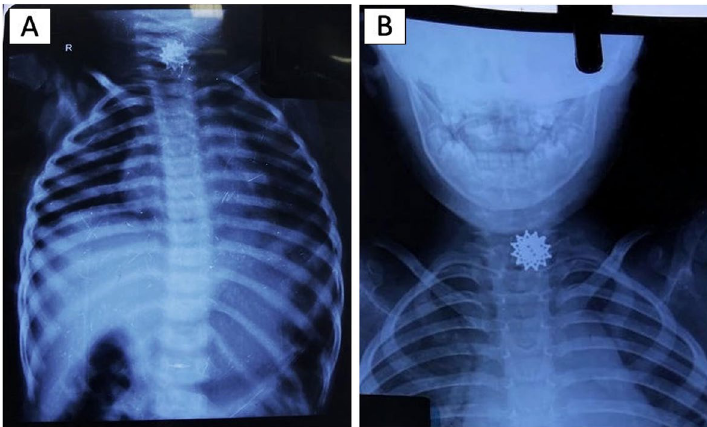
Fig. 1 A Chest X-ray antero-posterior view showing the foreign body in the upper part of the esophagus. B Enlarged view of foreign body